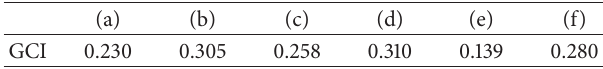
Figure 3: The spherical surface of a regular workspace. Table 1: The GCI corresponding to the six designs in Figure